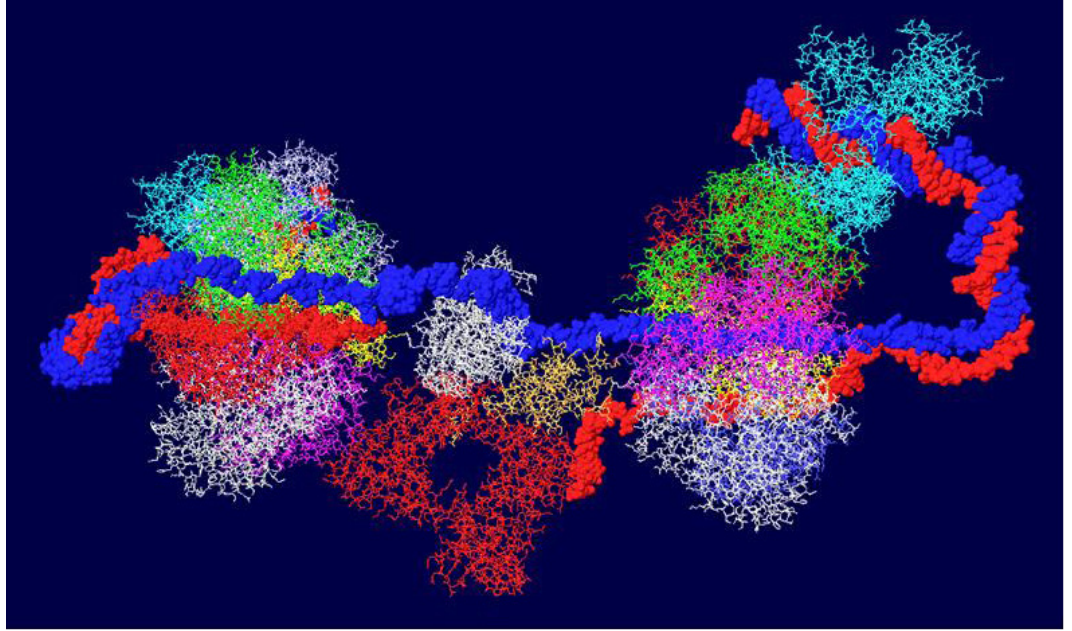
Figure 9. Model of DH with topo I bound to the N-terminal site. The structure shown in Figure 7 was fitted onto a model of topo I:J domain:RPA70 (Figure 10C). There are no clashes in this structure, but for clarity, the OBDs, part of the red DNA strand and its associated RPA were omitted. The model was also turned to show the molecule from the (cid:179)(cid:87)(cid:82)(cid:83)(cid:180)(cid:30)(cid:3)(cid:87)(cid:75)(cid:68)(cid:87)(cid:3)(cid:76)(cid:86)(cid:3)(cid:87)(cid:75)(cid:72)(cid:3)(cid:69)(cid:79)(cid:88)(cid:72)(cid:3)(cid:39)(cid:49)(cid:36)(cid:3)(cid:86)(cid:87)(cid:85)(cid:68)(cid:81)(cid:71)(cid:3)(cid:76)(cid:86)(cid:3)(cid:86)(cid:75)(cid:82)(cid:90)(cid:81)(cid:3)(cid:87)(cid:82)(cid:3)(cid:74)(cid:82)(cid:3)(cid:87)(cid:75)(cid:85)(cid:82)(cid:88)(cid:74)(cid:75)(cid:3)(cid:53)(cid:51)(cid:36)(cid:3)(cid:68)(cid:81)(cid:71)(cid:3)(cid:68)(cid:90)(cid:68)(cid:92)(cid:3)(cid:73)(cid:85)(cid:82)(cid:80) the viewer. The DNA from within the N-terminal bound topo I was also